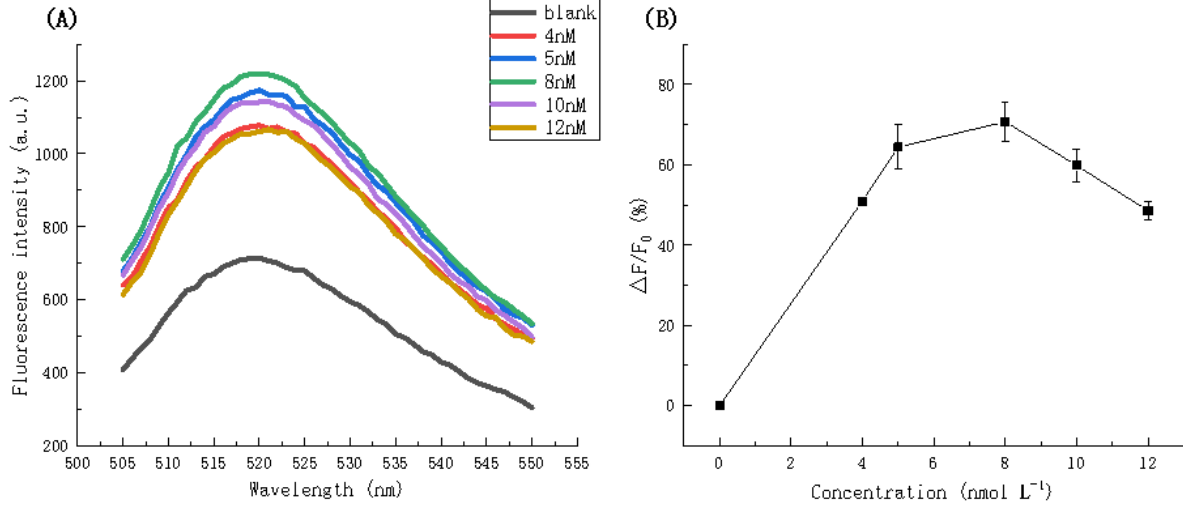
Figure 7. ( A ) Fluorescence spectra in the presence of different concentrations of H1 and H2. ( B ) Fluorescence intensity ratio ( △ F / F 0 ) at an emission wavelength of 520nm in the presence of different concentrations of H1 and H2.